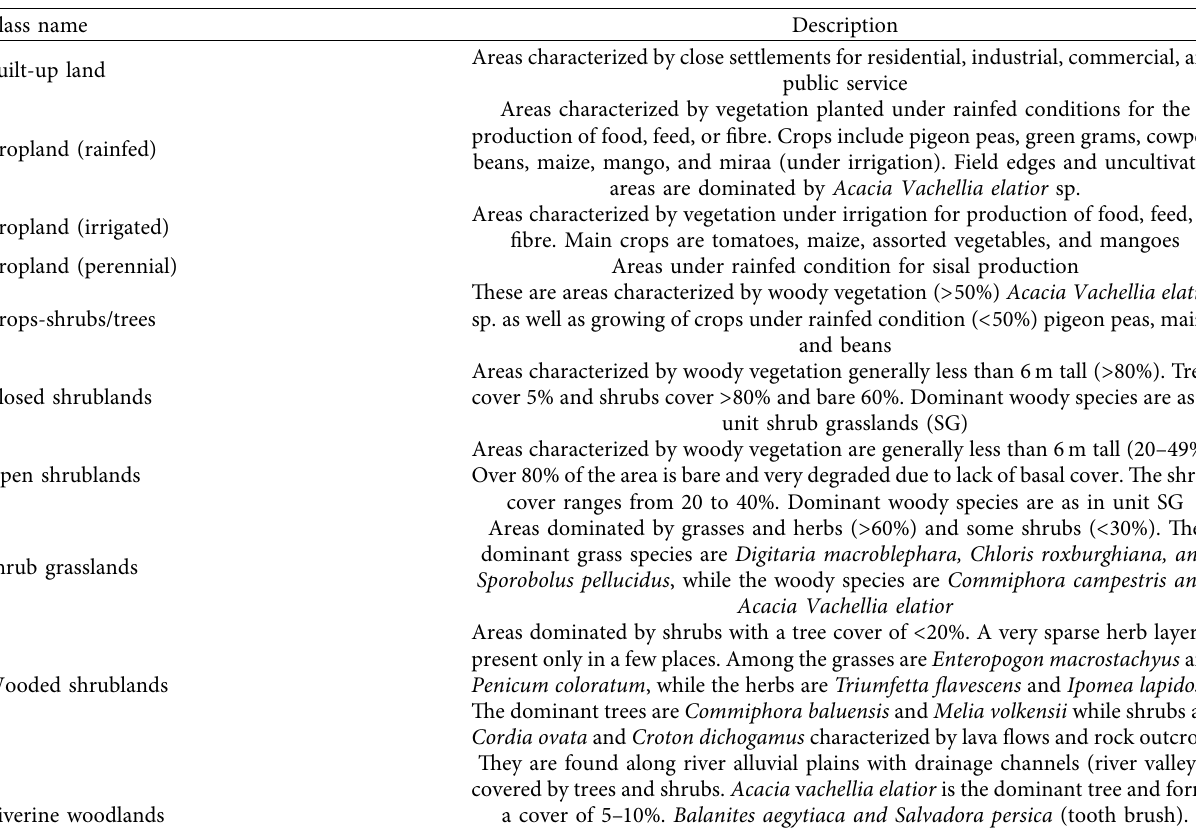
Table 2: LULC class and classifcation